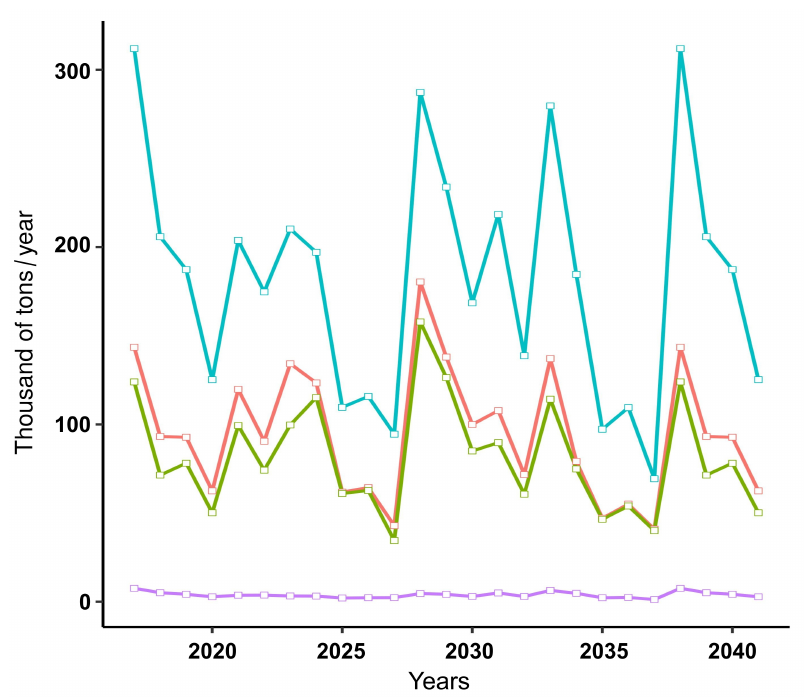
Figure 6. Projections of Eucalyptus grandis biomass production considering scenarios described in Table 7. Total residues (cyan); scenario I, wood and branches below 6 cm in diameter (purple); scenario II, wood from logs with a diameter between 6 and 19 cm (green); and scenario III, wood from logs with a diameter less than 19 cm and 50% of harvested branches